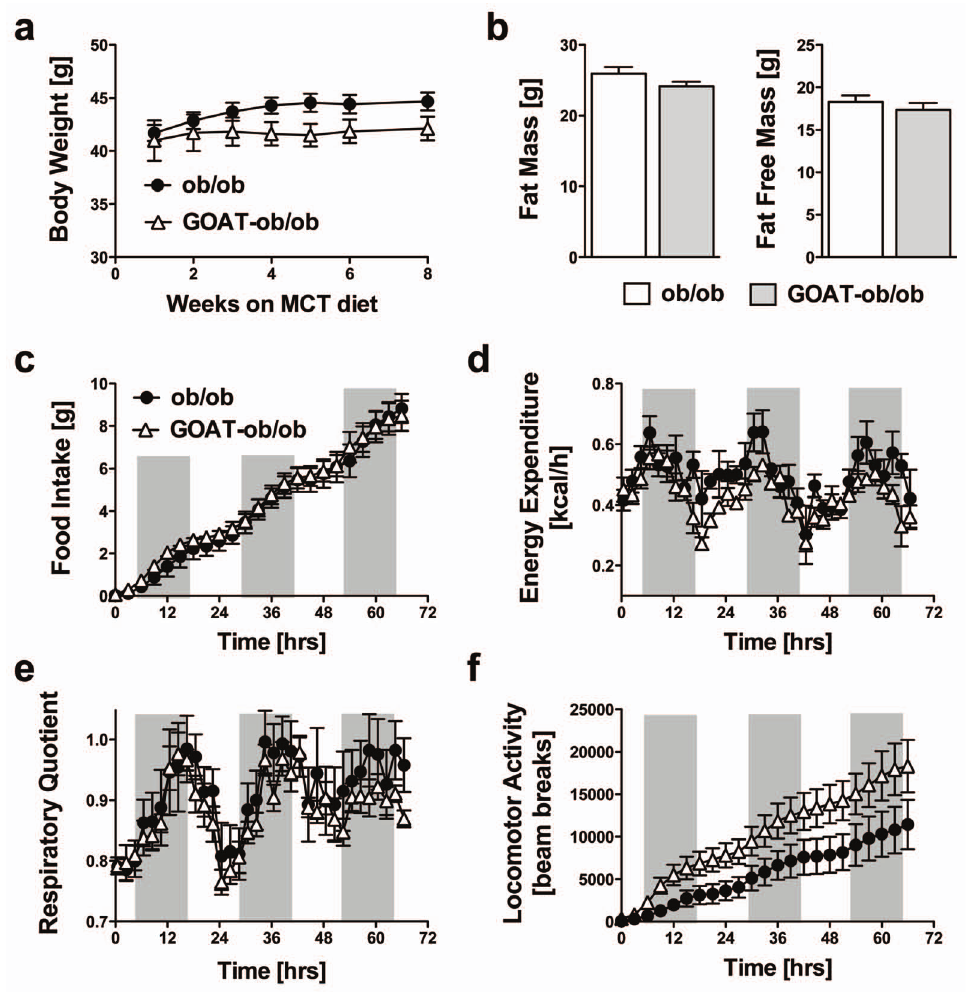
Figure 3. Metabolic phenotypes of ob/ob mutants and GOAT-ob/ob double mutants after exposure to medium-chain triglyceride (MCT) enriched diet. Leptin-deficient ob/ob and GOAT-ob/ob double mutant mice were fed MCT diet for 8 weeks. No differences were observed for body weight (a) and fat mass or fat free mass (b). Further, indirect calorimetry after 7 weeks of MCT diet exposure revealed no differences in food intake (c), energy expenditure (d), respiratory quotients (e) or locomotor activity (f, P=0.16). (n=4–7).